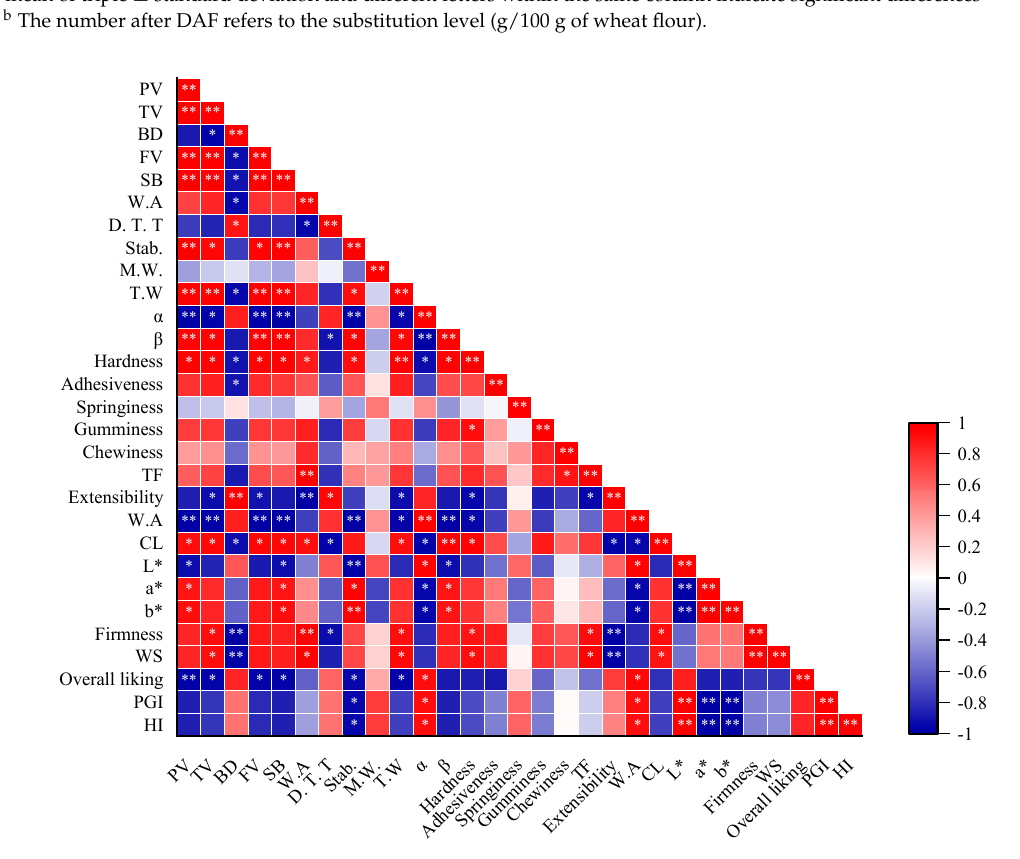
Table 4. Cooking quality and color attributes of wheat noodles with different substitution levels a .